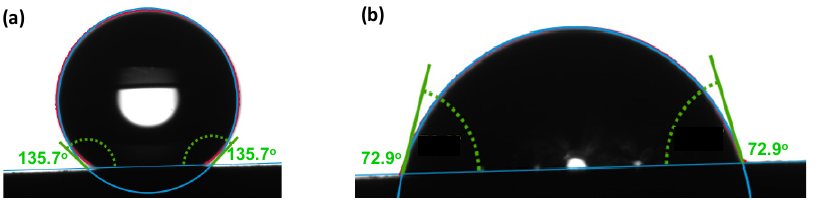
Figure 16. How the presence of AlN in a material improves its non-wetting properties, ( a ) a coating with 82% AlN shows contact angle of 136°, and ( b ) a coating with 25% AlN shows contact angle of about 73°.